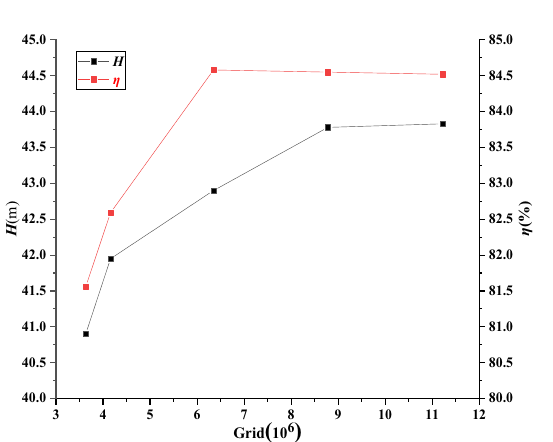
Figure 4. Grid independence test.